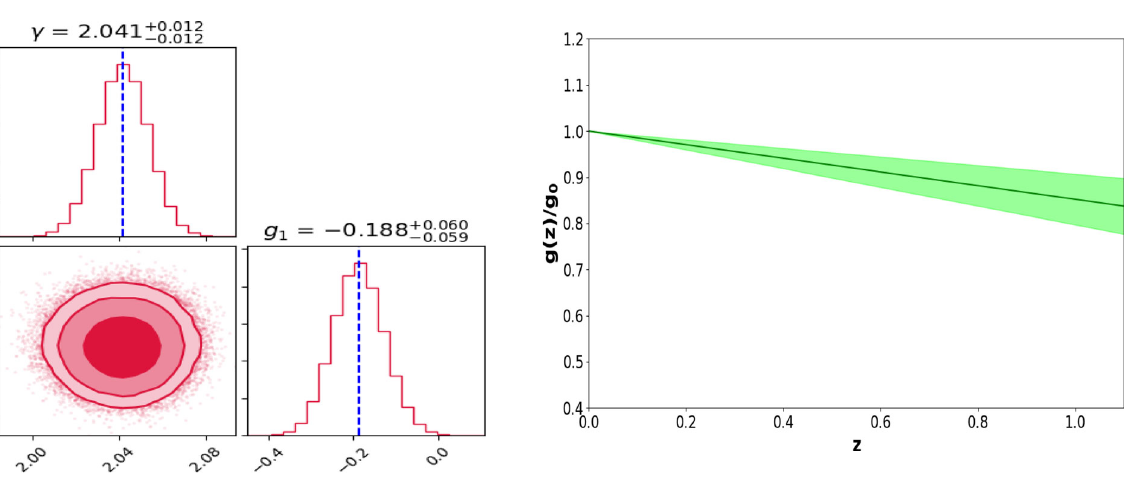
Fig. 7 The evolution of the normalized gas depletion factor along with 1 σ error band as a function of redshift using 40 X-ray f gas measure- ments near r 2500 from [1]. This figure shows a mild evolution of g ( z ) with respect to